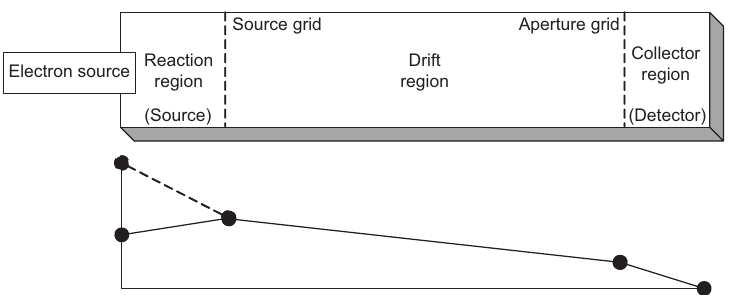
Figure 1 Typical set-up of an ion mobility spectrometer with its three sections (upper drawing). In the reaction region, the analyte mol- ecules are continuously ionized. Electric fields accelerate the ions with a certain frequency into the drift region, which they cross with dif- ferent flight times because of their different mobilities in air. In the collector region, a detector forms the signal proportional to the amount of ions. The lower graph illustrates the voltages applied to each